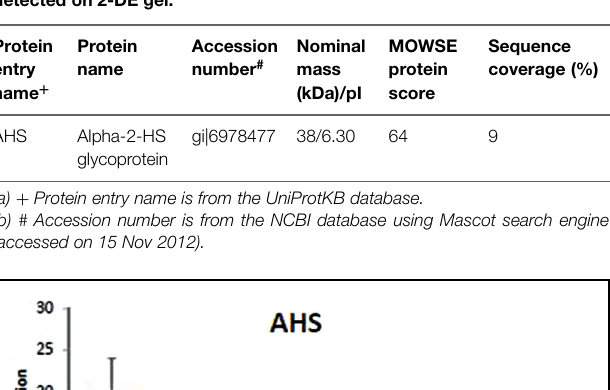
TABLE 3 | Identification of the differentially expressed rat serum protein detected on 2-DE gel.